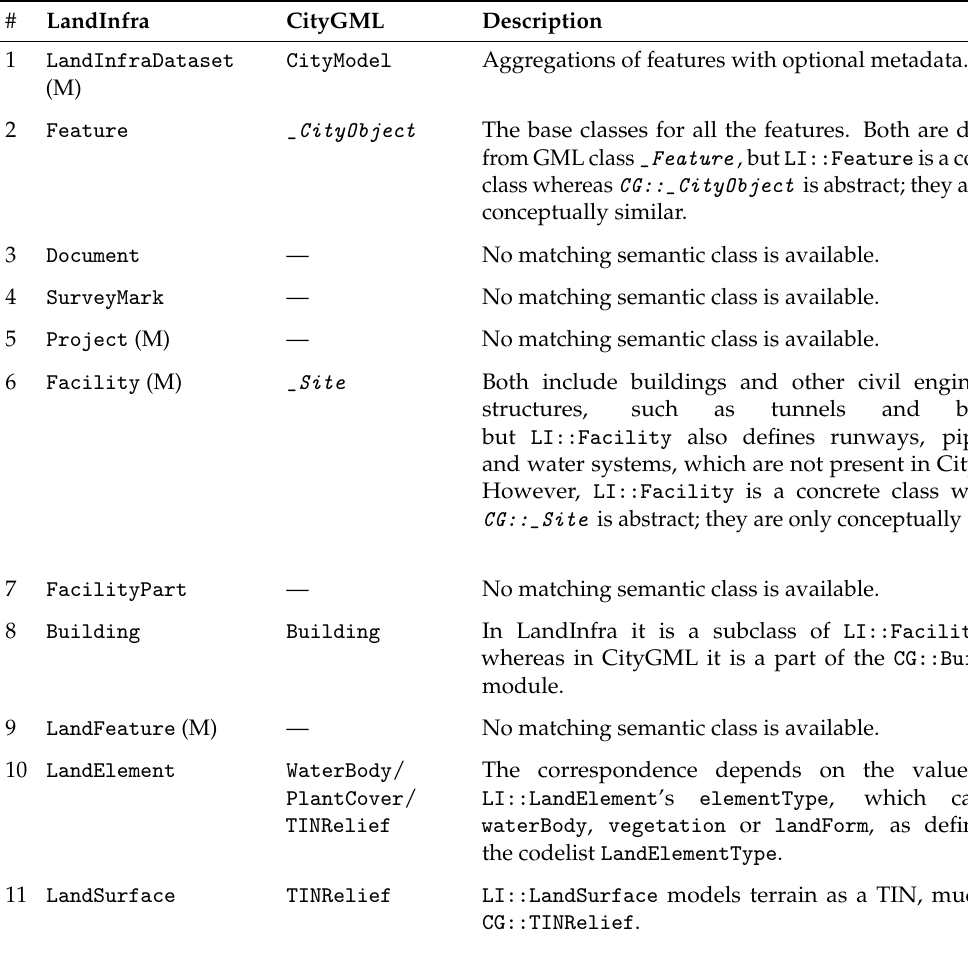
Table 2. Mapping between the LandInfra conceptual model and CityGML. For simplicity, we only show here the mapping for all the LandInfra main requirement classes (marked with M) and a few other LandInfra classes as